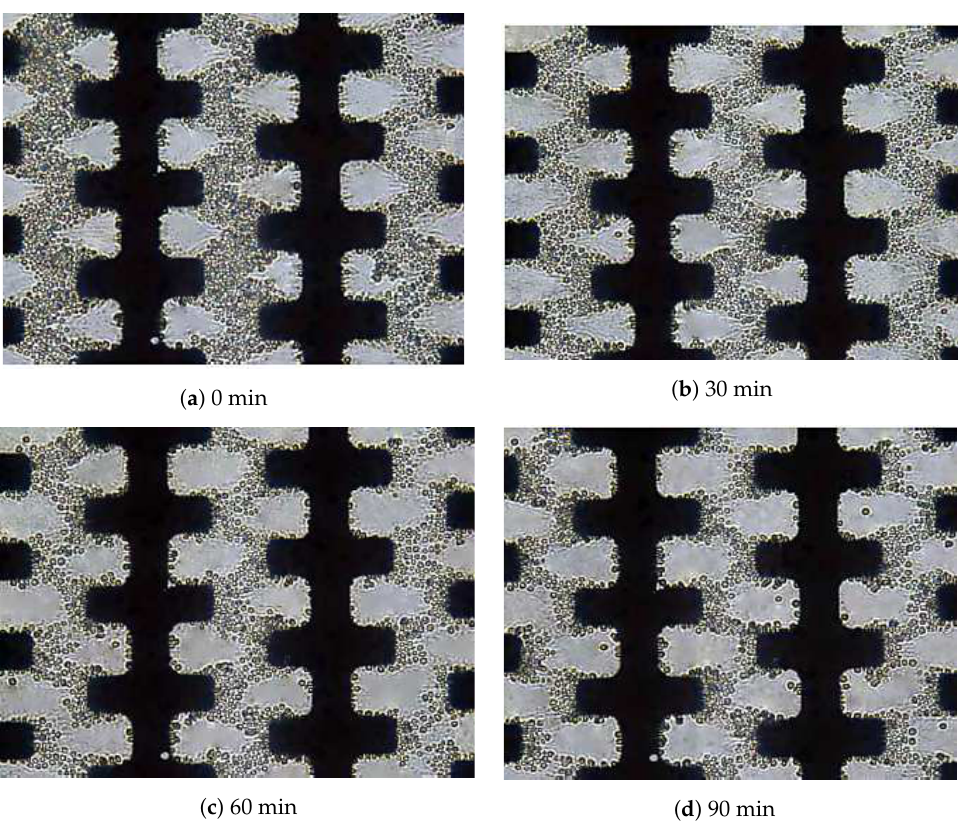
Figure 6. After 90 min of separation time, the S. cerevisiae concentration reduced gradually from the microelectrodes array 500 at a low conductivity σ m of 40µS/cm, a pulsing time of 12 s and a high fluid flow of 9.6 µ L min − 1 . The flow direction was from left to